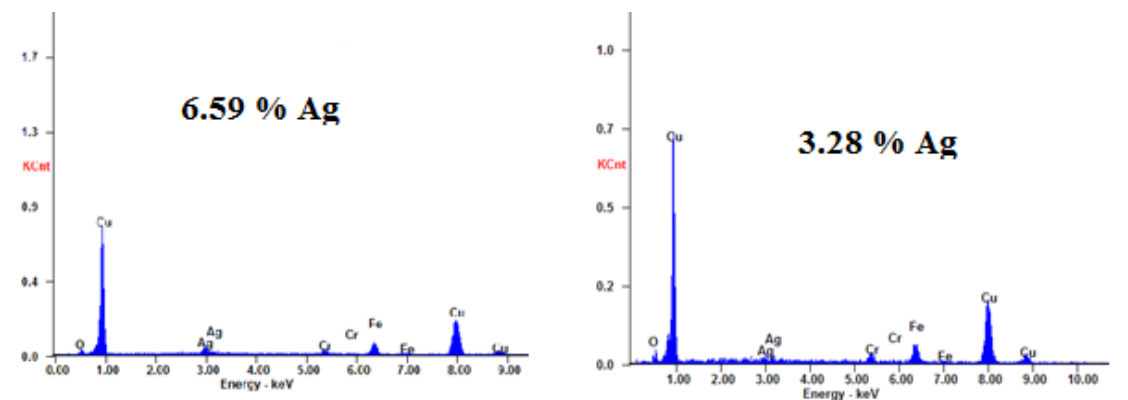
Figure 8. Mapping showing the distribution of the elements: ( a ) Ag; ( b ) Cu; ( c ) CuAg; and ( d ) orig- inal sample.